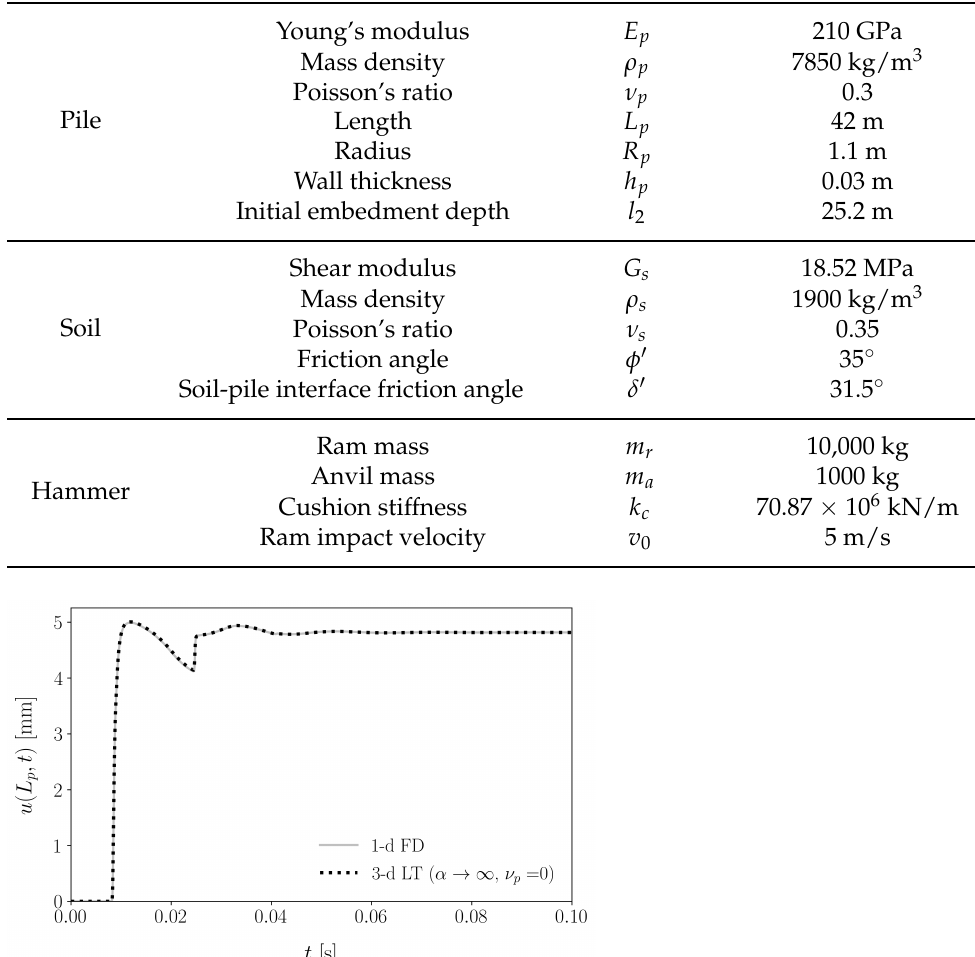
Table 1. Parameters of the validation case.